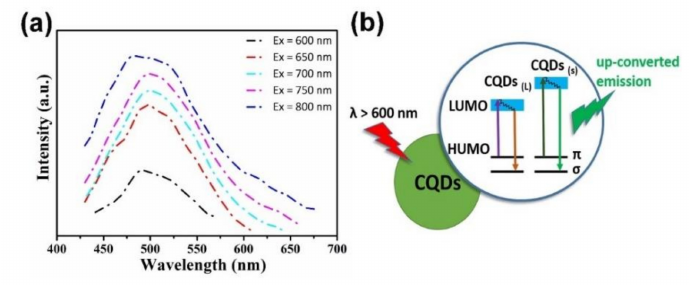
Figure 10. ( a ). Up-conversion photoluminescence properties of C-dots from walnut shells, ( b ). the upconversion processes in C-dots of di ff erent particle sizes